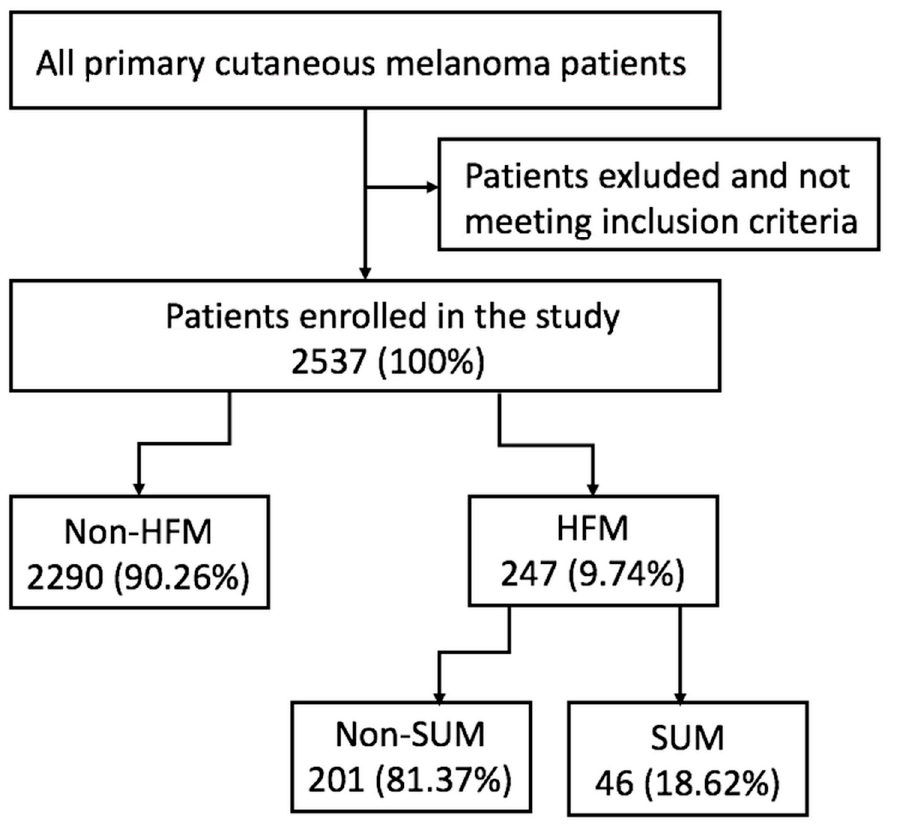
Figure 1. Data extraction flow chart. Legend: HFM—hand and foot melanoma, SUM—subungual melanoma. Table 1. Clinicopathological features of non-HFM vs. HFM